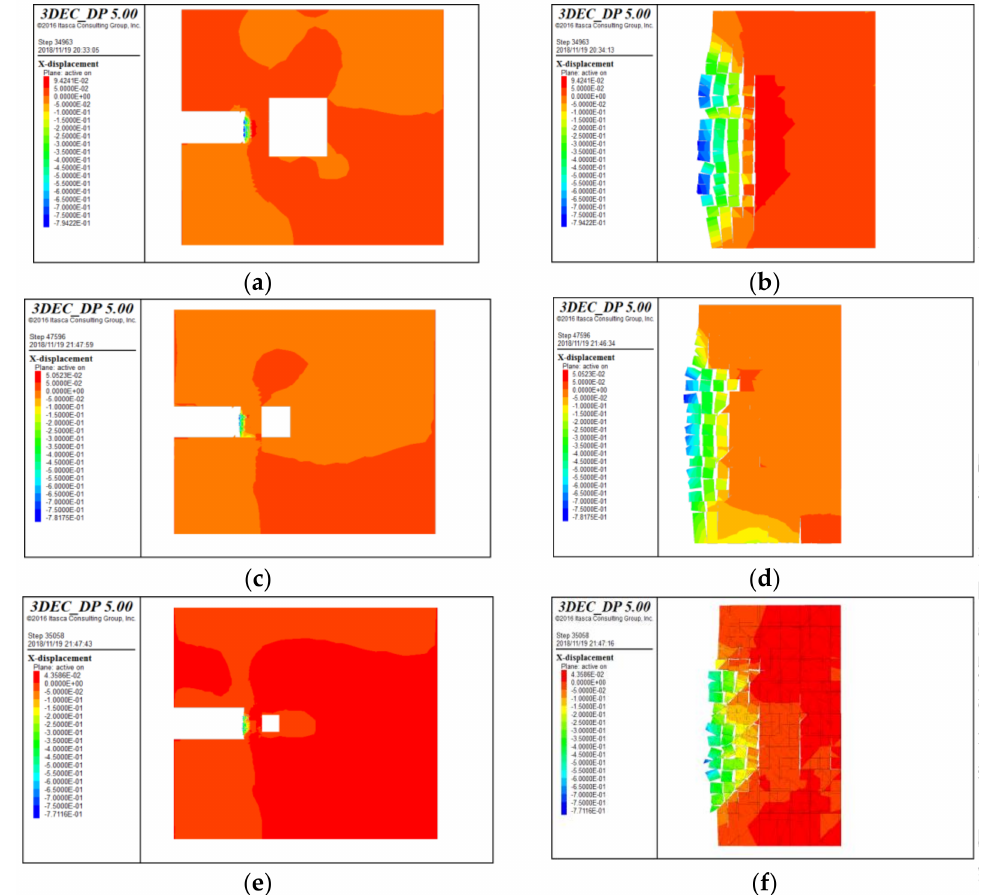
Figure 12. Displacement nephogram of each water-resistant stratum when it was destroyed. ( a ) Large cavity; ( b ) Partial enlarged drawing for tunnel face with a large cavity; ( c ) Medium cavity; ( d ) Partial enlarged drawing for tunnel face with a medium cavity; ( e ) Small cavity; ( f ) Partial enlarged drawing for tunnel face with a small